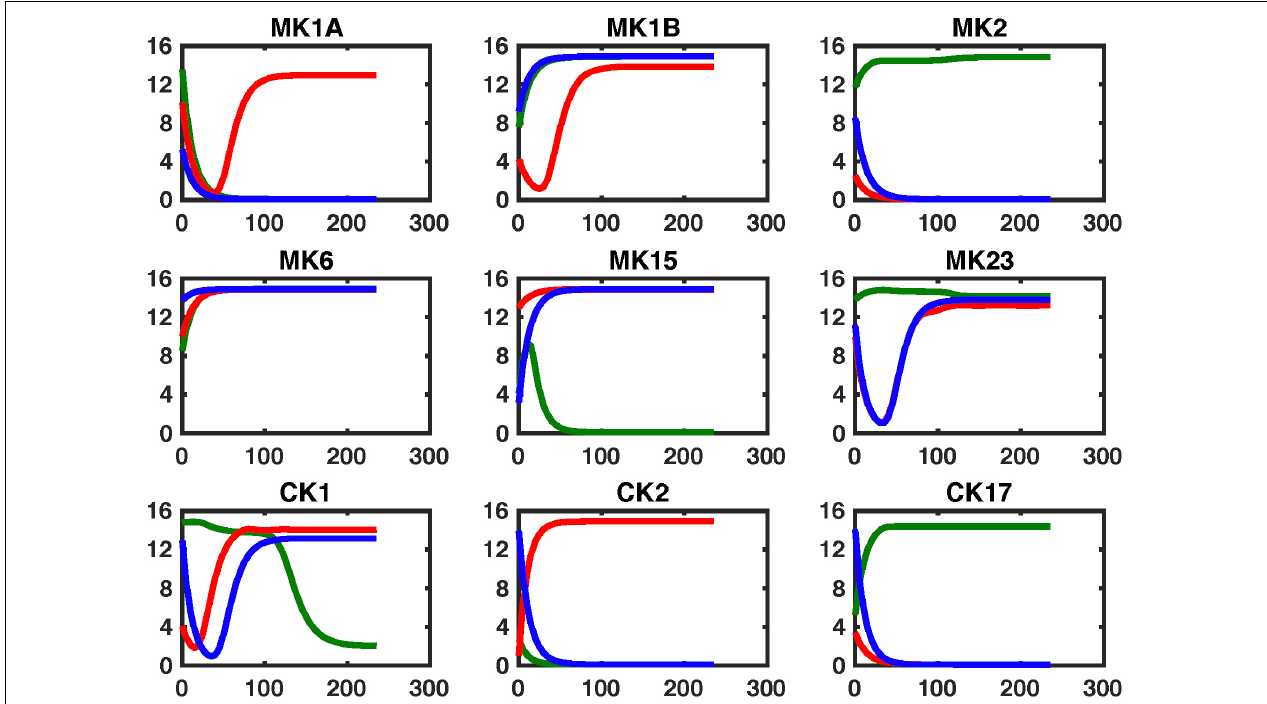
FIGURE 6 | Simulating regulatory circuit response to MK6 and MK23 antagonism. Simulated response to a step perturbation applied to the characteristic circuits for GWI (GWI, red line), healthy control (HC, green line), as well as the pharmaceutically edited GWI network (Treated, blue line). Improved adherence to output from the healthy control circuit are produced for cytokine sets MK1A, MK1B, and CK2 without significant negative effects on other sets.